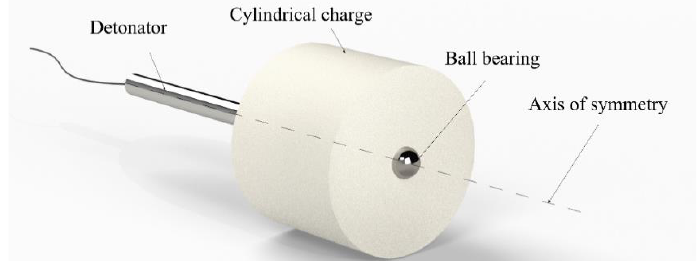
Fig. 1 Schematic showing a rear-detonated PE-4 explosive charge with a ball bearing embedded in the front surface.